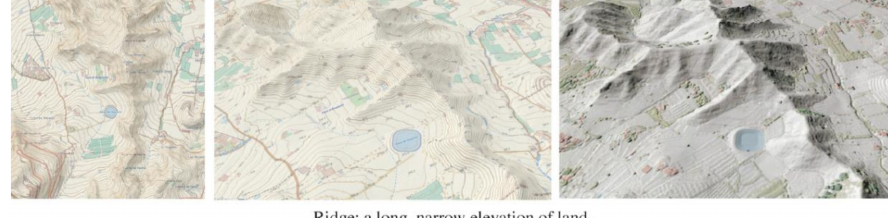
Figure 1. Example of the definition of a ridge in the specific training phase on landforms. ( Left ) A contour lines map in 2D. ( Center ) A contour lines map in 2D. ( Right ) A Light Detection and Ranging (LiDAR) Digital Elevation